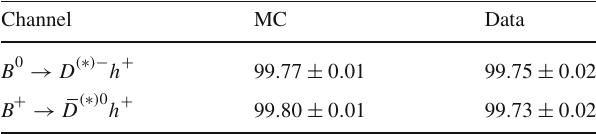
Table 3 Tagging efficiencies ε ± δε for charged and neutral B → ( ∗ ) + D h candidates in data and in simulation. All values are given in percent. The uncertainties are only